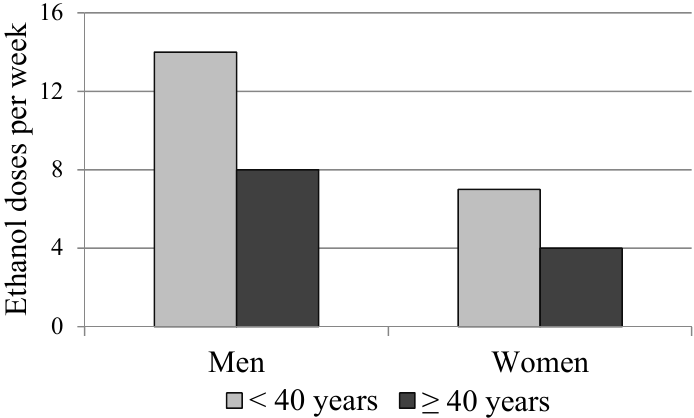
Figure 1. Threshold levels of alcohol consumption (standard drink units/week) for initiating GGT activation in individuals below and above 40 years of age. Alcohol consumption was recorded from the past one year prior to sampling [116]. The levels leading to GGT increases are markedly lower than the current limits of heavy drinking in many Western countries (men: 24 drinks, women: 16 drinks).